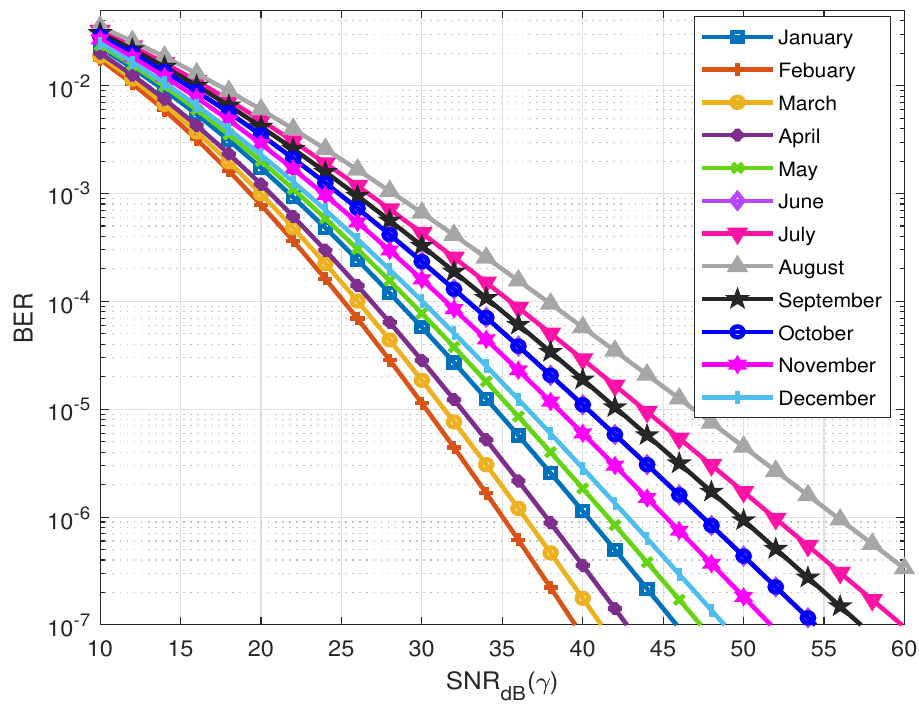
Figure 3. The observation of BER performance for whole year in North ocean. The performances are simulated on monthly basis average temperature, conductivity in the year